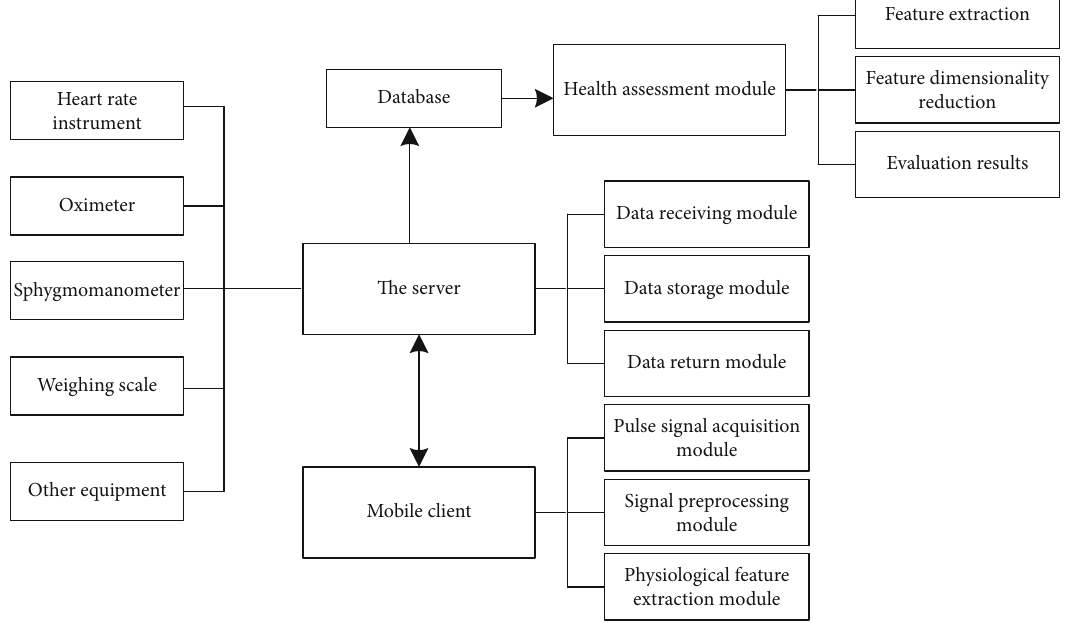
Figure 2: Human body state information recognition model management mechanism after sports training.